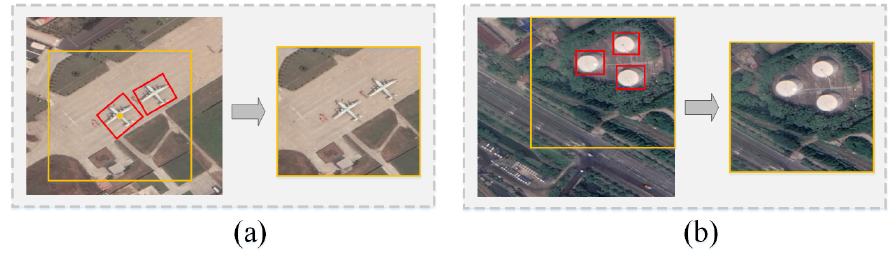
Figure 4. CLRS construction process based on the target detection pretrained model. Step1: Cropping the remote sensing image into 1024 × 1024 to satisfy the model input size. Step2: The target location information is obtained by YOLOV2 detection. Step3: The image was cropped to 256 × 256 size according to the detected coordinate range.